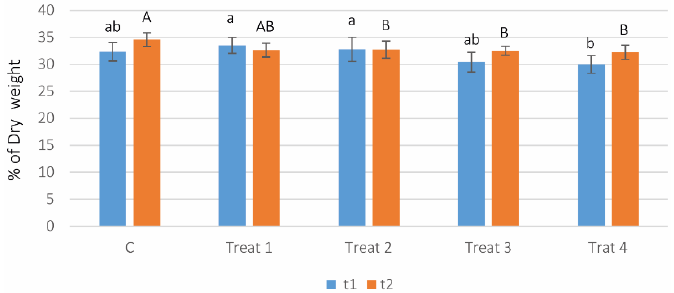
Figure 5. Percent of dry weight in hop leaves in each treatment at the two times (t1 and t2). Different letters indicate significant differences ( p < 0.05). Lowercase letters are used for t1 results, and capital letters are used for t2 results.